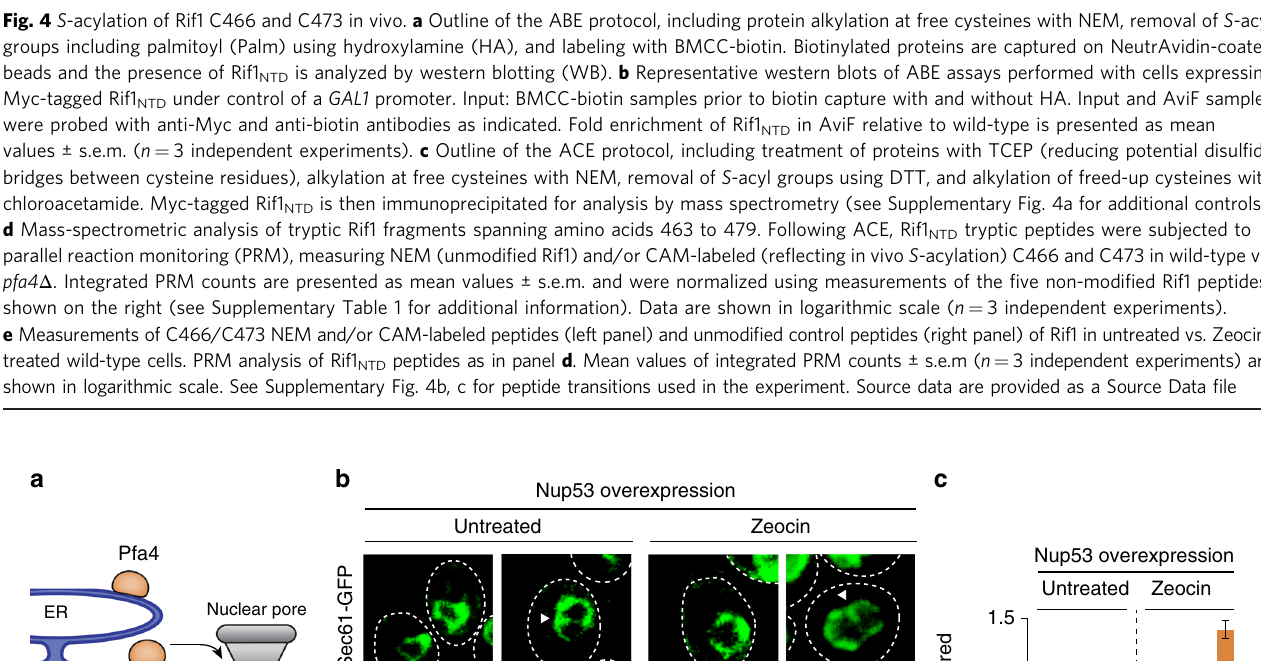
Fig. 5 Pfa4 associates with the inner nuclear membrane. a Pfa4 localizes to the endoplasmic reticulum (ER) 43 but access to the inner nuclear membrane has not been demonstrated. b Cells with theta ( θ ) nuclei, induced by Nup53 overexpression-mediated inner nuclear membrane proliferation, were analyzed for inner nuclear membrane-association of Sec61-GFP, Hrd1-GFP, and Pfa4-GFP (arrowheads indicate GFP-positive θ structures). Representative Z- projections of confocal microscopy images are shown for cells treated or not with Zeocin. Scale bar: 5 μ m. c Quanti fi cation of the analysis shown in panel b . Results from three independent experiments ( n ≥ 400 total cells per strain and condition) are shown as mean values ±